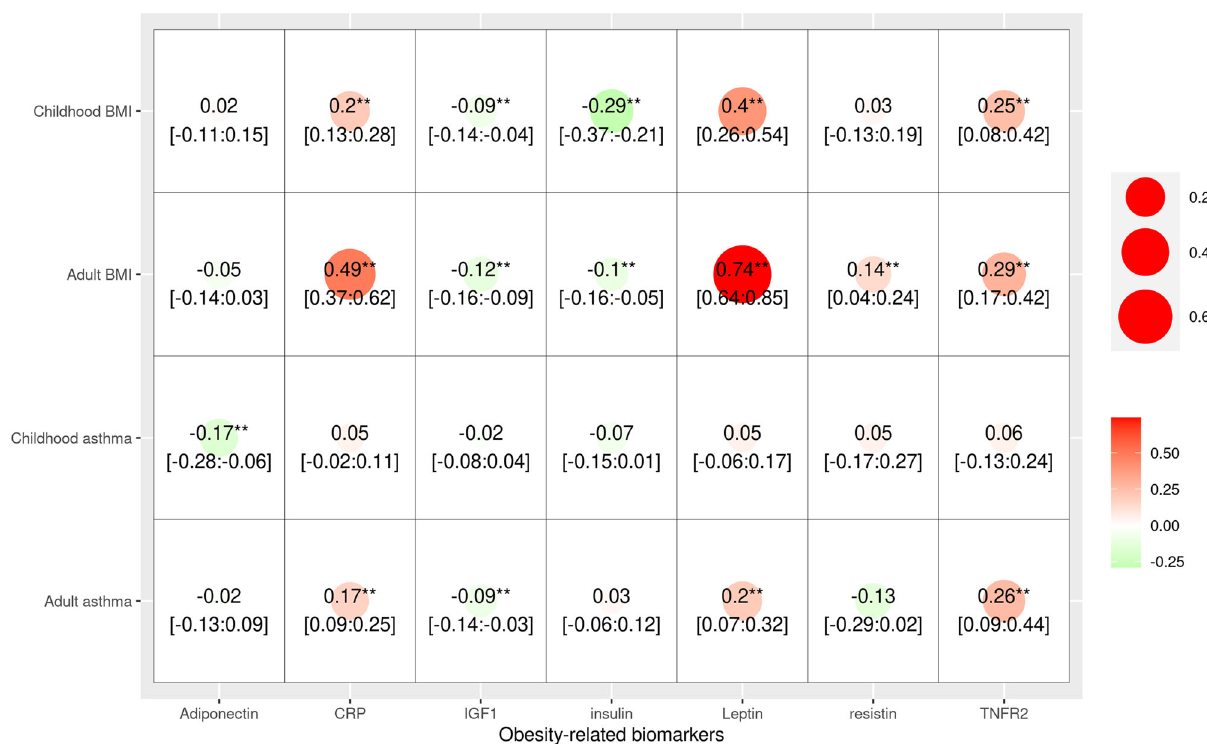
Fig. 5 Genome-wide genetic correlation between obesity-related biomarkers and childhood- and adult-onset asthma. The direction of genetic correlation is presented in different colors, and the magnitude of genetic correlation is shown in different point sizes. The genetic correlation coef fi cients and the 95% con fi dence intervals (CI) are shown in each cell. The nominal signi fi cance level of genetic correlation ( P < 0.05) is marked by one asterisk, and P < 0.01 is marked by two asterisks. The calculation of genetic correlation for IL-6 and TNFR1 failed due to computing